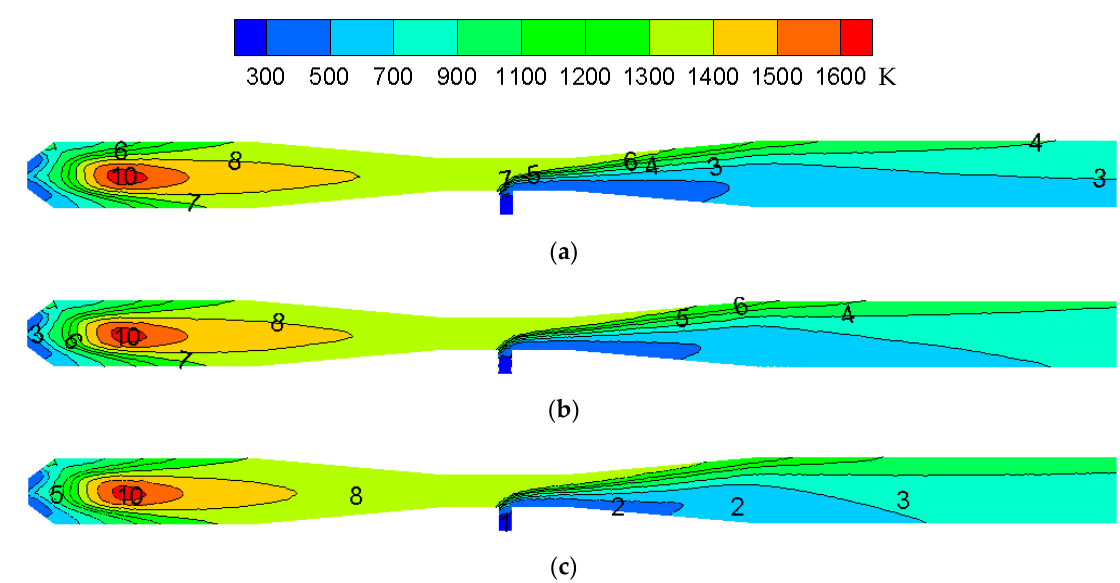
Figure 5. The comparison of temperature distribution in the reactor after amplification: ( a ) magnified by 8 times ( b ) magnified by 10 times ( c ) magnified by 12 times.